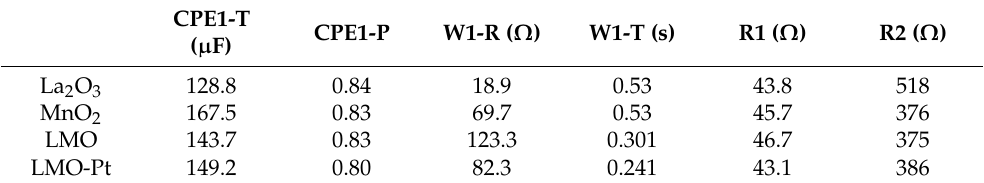
Table 3. Galvanostatic electrochemical impedance spectroscopy data for La 2 O 3 , MnO 2 , LMO, and LMO-Pt in O 2 -saturated 0.10 M KOH obtained at I s = − 0.765 mA cm − 2 with an amplitude of 0.510 mA cm − 2